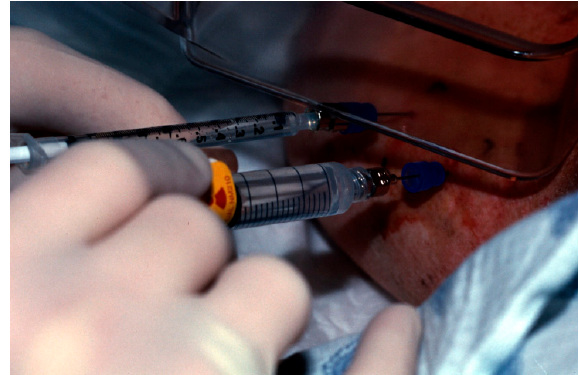
Figure 7. A tuberculin syringe containing saline is attached to the far needle. Tc-99m-sulfur colloid is injected into the near needle for SLNB.